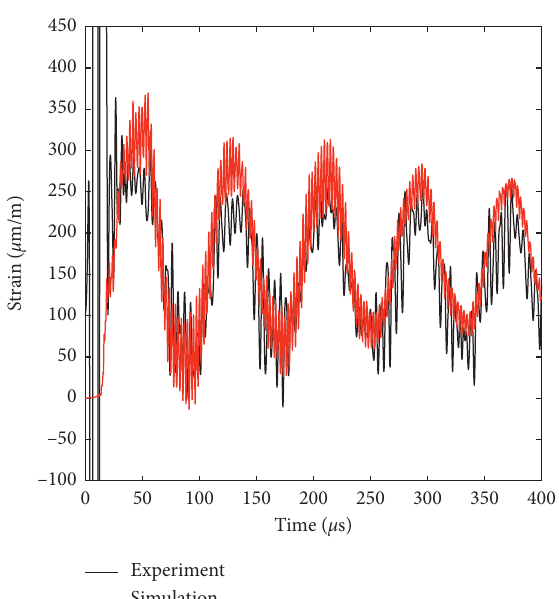
Figure 23: Longitudinal strain for shot 132, probed at a length of 154 mm on the bottom face of the second specimen. The numerical model with Young’s modulus of 220GPa and the multilinear hardening